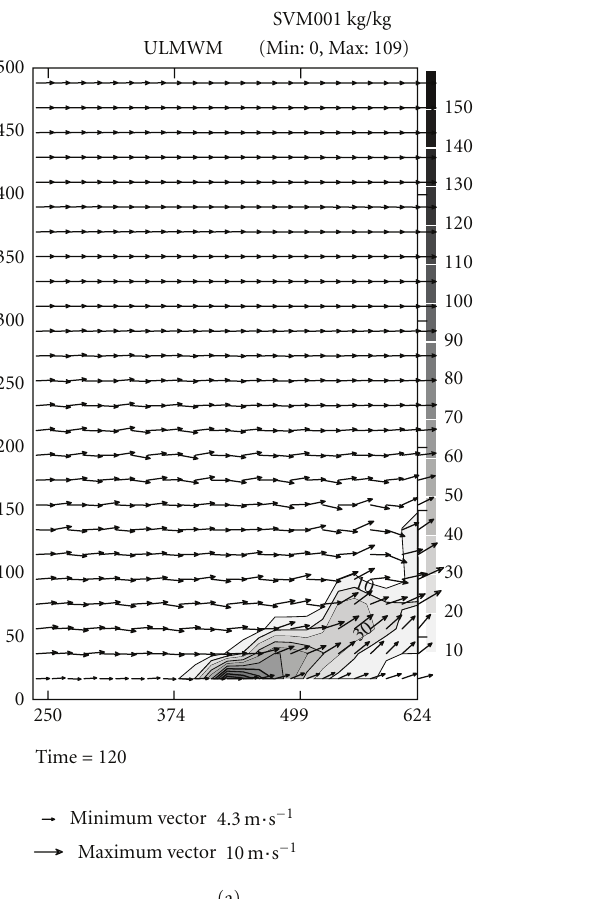
Results for the ridge test case are presented in Figure